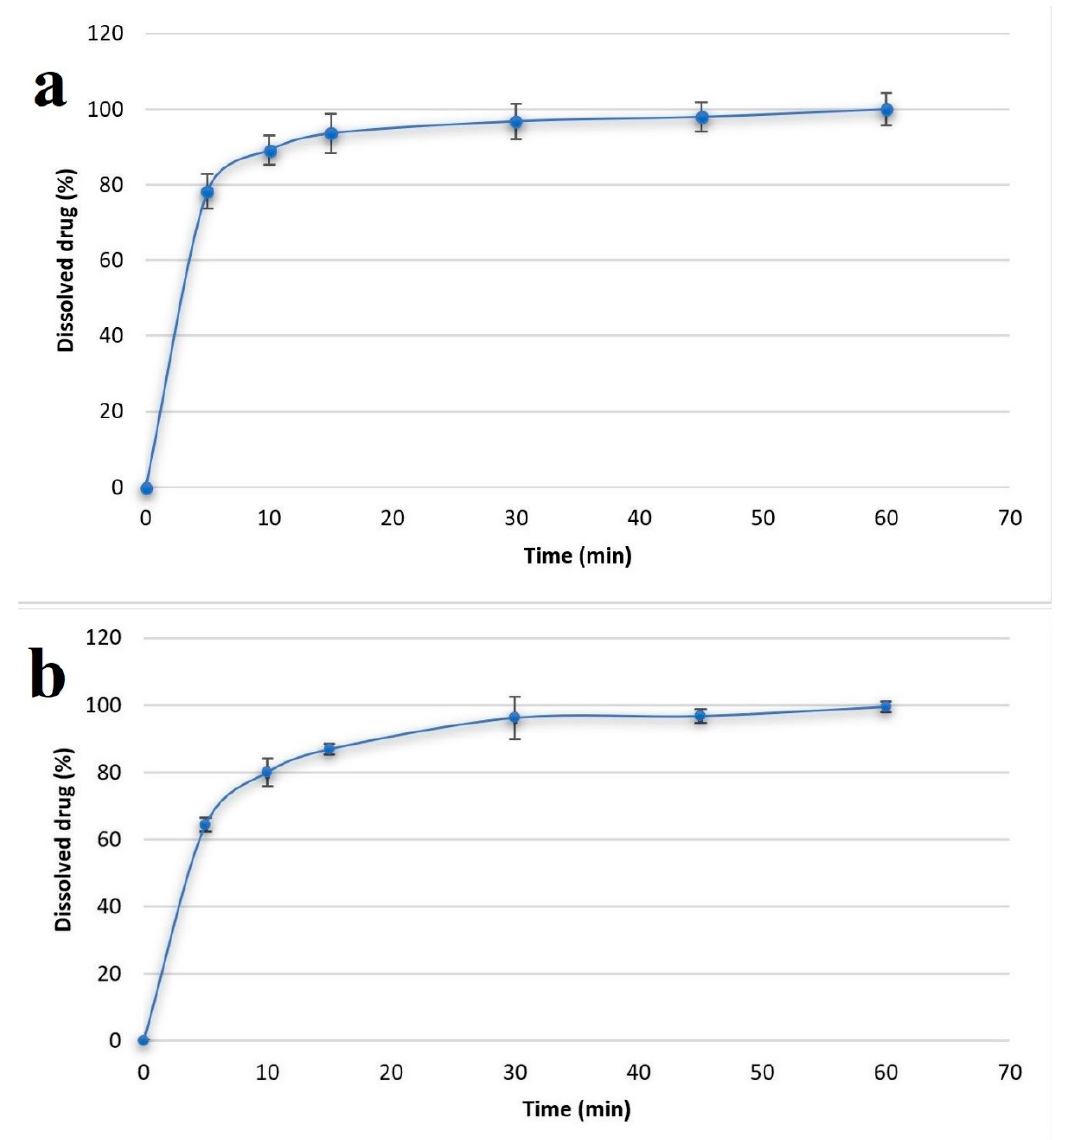
Figure 12. The dissolution curves in the case of diclofenac Na ( a ) and cetirizine HCl-loaded film ( b ).